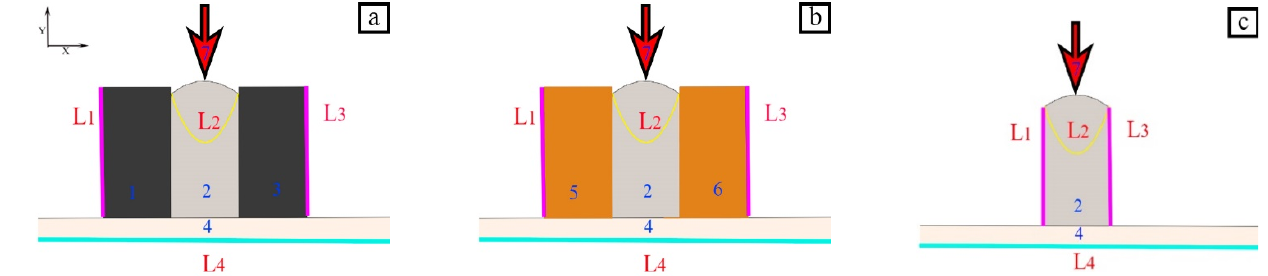
Figure 2. 2D cross-sectional view of modeled workpieces obtained by multilayer build-up welding with indication of elements and boundary conditions: ( а ) specimen № 1; ( b ) specimen № 2, ( c ) specimen № 3. 1 and 3—heat-transfer limiters (shaping graphite blocks); 2—specimen;.4—substrate; 5 and 6—heat-removing limiters (shaping copper blocks); 7—heat source.